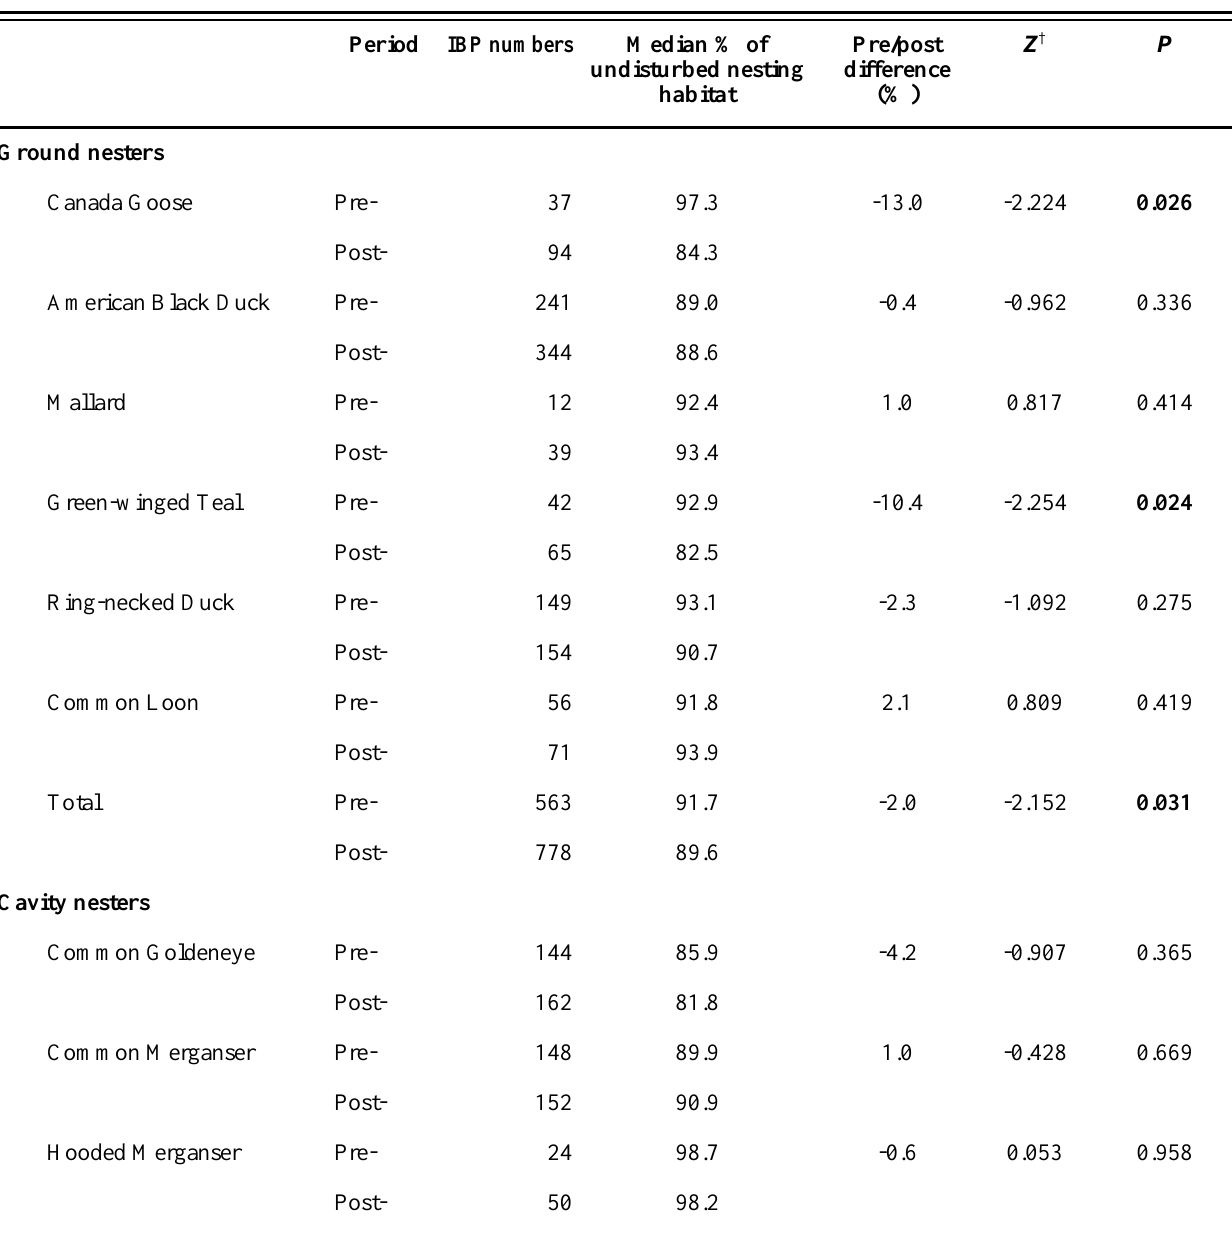
Table 1. Results of the nonparametric Mann-Whitney U -tests comparing pre- and post-harvest distributions of the percentage of nesting habitat left undisturbed by timber harvesting within a 1-km radius of indicated breeding pair (IBP) locations. Tests include all IBP located within 2 km of clear-cut areas. Median percentages of undisturbed nesting habitat and pre/post median differences are presented: a negative difference indicates a lower undisturbed nesting habitat (higher % of clear-cut) after treatment than before, and vice-versa. Statistics are given for all individual species totaling over 30 IBP, for guilds of ground nesters and cavity nesters, and for all species